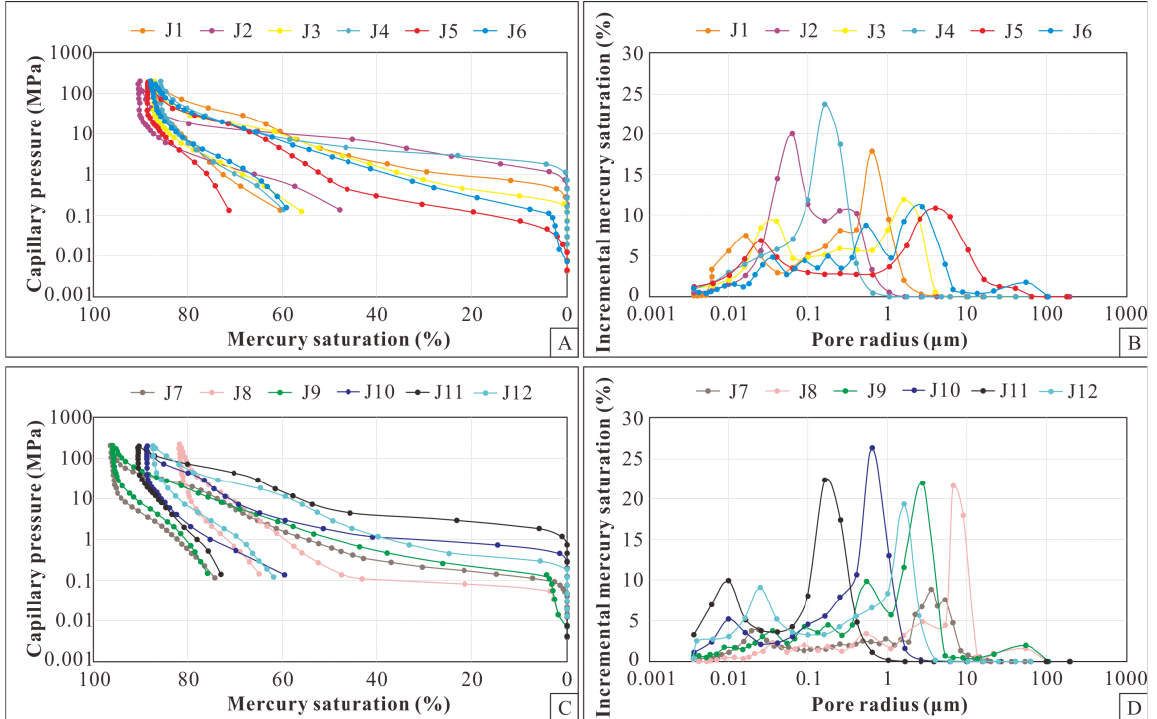
Figure 6. ( A ) HPMI curves of samples J1–J6; ( B ) pore-throat radius and mercury saturation increment distribution of samples J1–J6; ( C ) HPMI curves of samples J7–J12; ( D ) pore-throat radius and mercury saturation increment distribution of samples J7–J12.